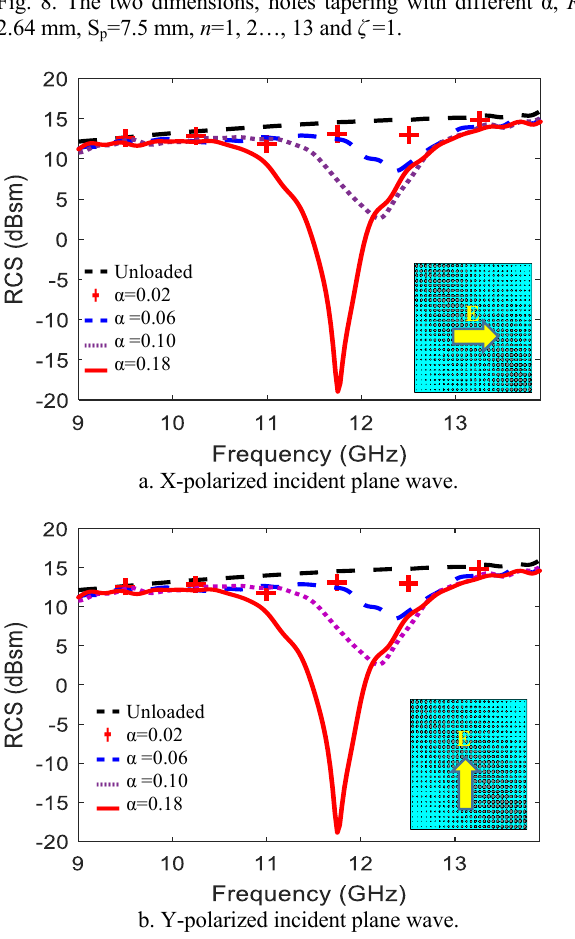
Fig. 9. The RCS versus frequency for two dimension holes tapering off-diagonal with different α, R o = 2.64 mm.